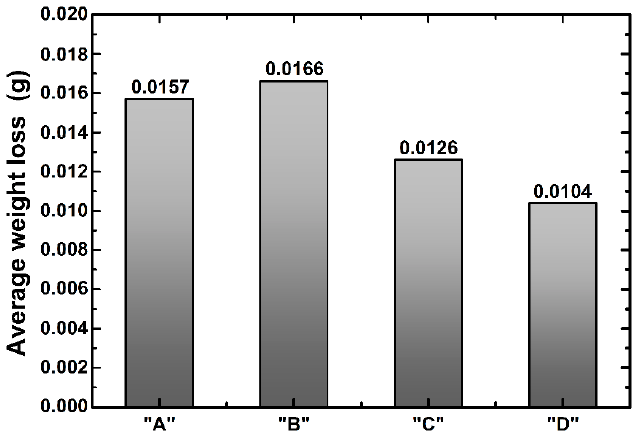
Figure 8. Average weight loss of tested samples after abrasion wear test.